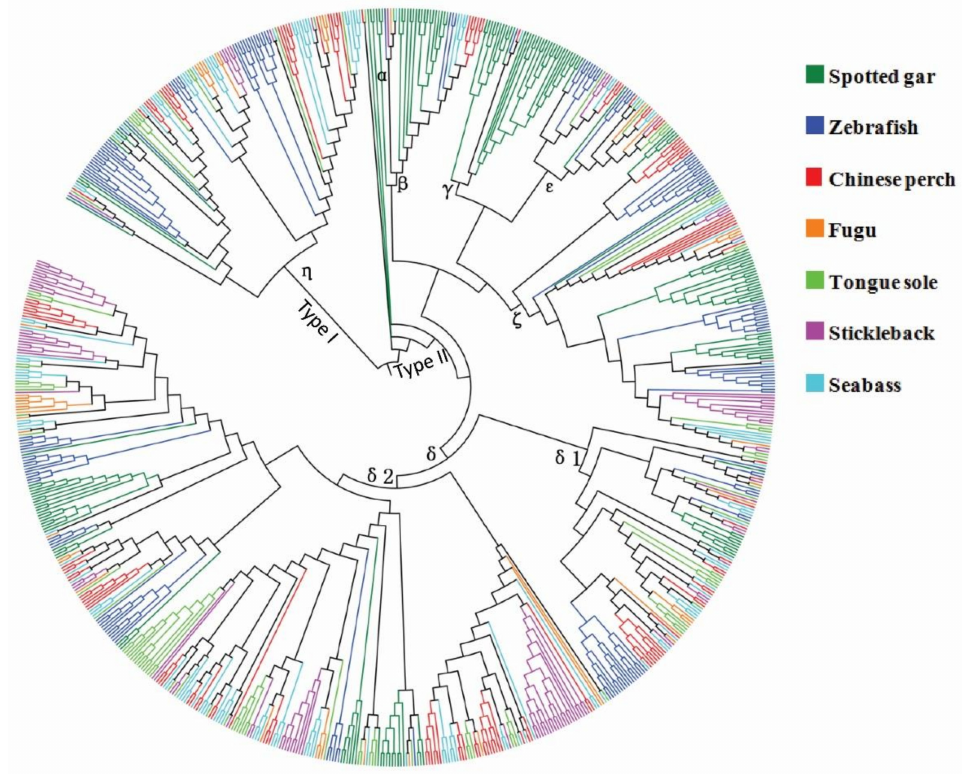
Figure 2. A phylogenetic tree of OR functional genes from Chinese perch and six other teleost genomes (n = 808) (see also Supplementary datas 2 and 3). Legends are indicated on the upper left-side of the figure. Groups named α to η are signed on the branches. All of the major clades have bootstrap values greater than